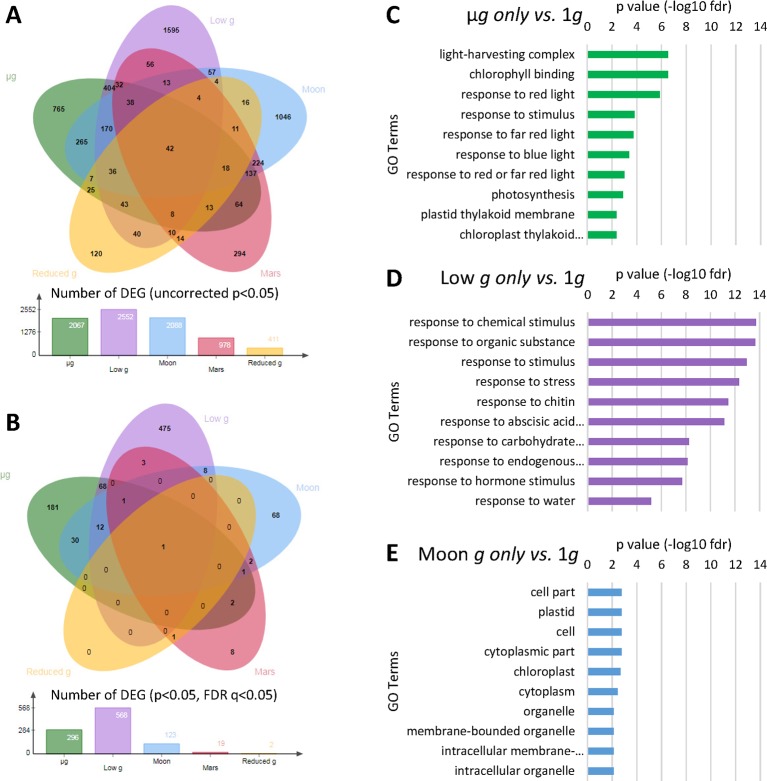
Differentially expressed genes (DEGs) across the different gravity levels. (A) Venn diagram classifying DEGs using uncorrected p-value (p < 0.05). (B) Venn diagram classifying DEGs including an adjusted FDR q-value (p and q < 0.05). (C) Ten most significant gene ontology (BinGO GO Full Enrichment) categories from DEG in µg vs. 1g only (FDR q < 0.05). (D) Ten most significant gene ontology (BinGO GO Full Enrichment) categories from DEG in low gravity (circa 0.1g) vs. 1g only (FDR q < 0.05). (E) Ten most significant gene ontology (BinGO GO Full Enrichment) categories from DEG in Moon gravity vs. 1g only (FDR q < 0.05).